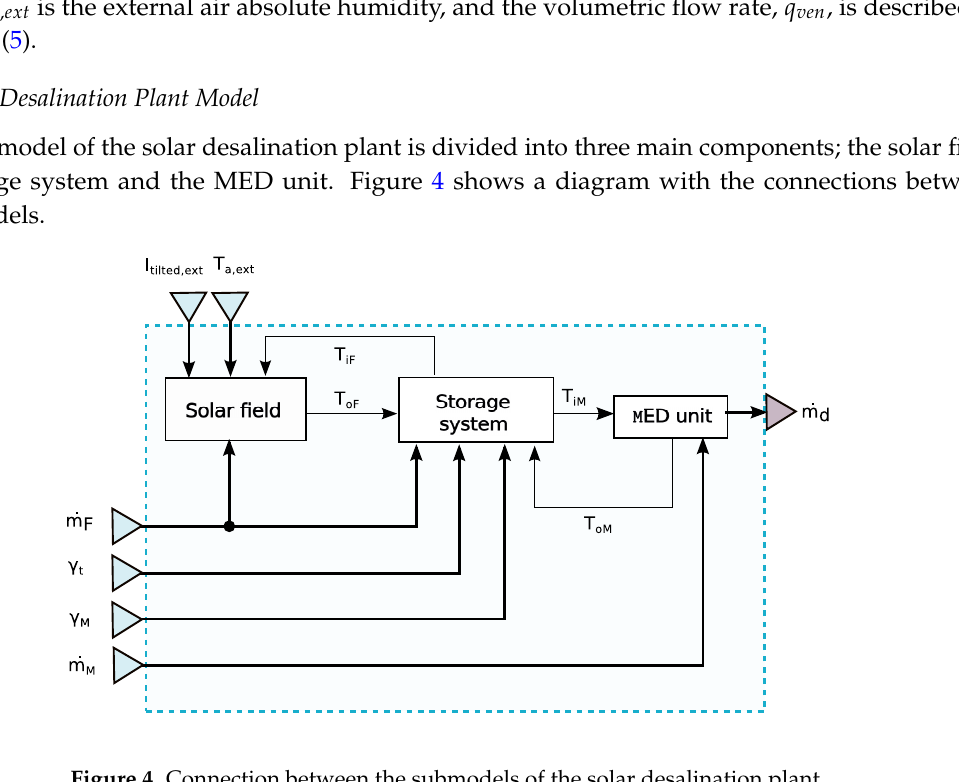
Figure 4. Connection between the submodels of the solar desalination